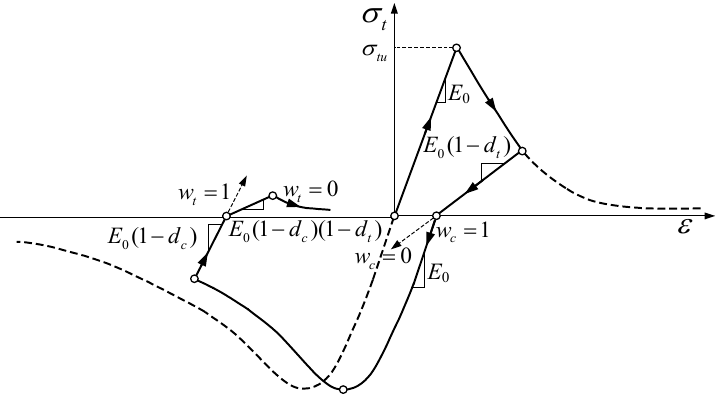
Figure 4. Stress ‐ strain relations under uniaxial cycle loading of concrete damage plasticity (CDP) Figure 4. Stress-strain relations under uniaxial cycle loading of concrete damage plasticity model. (CDP)